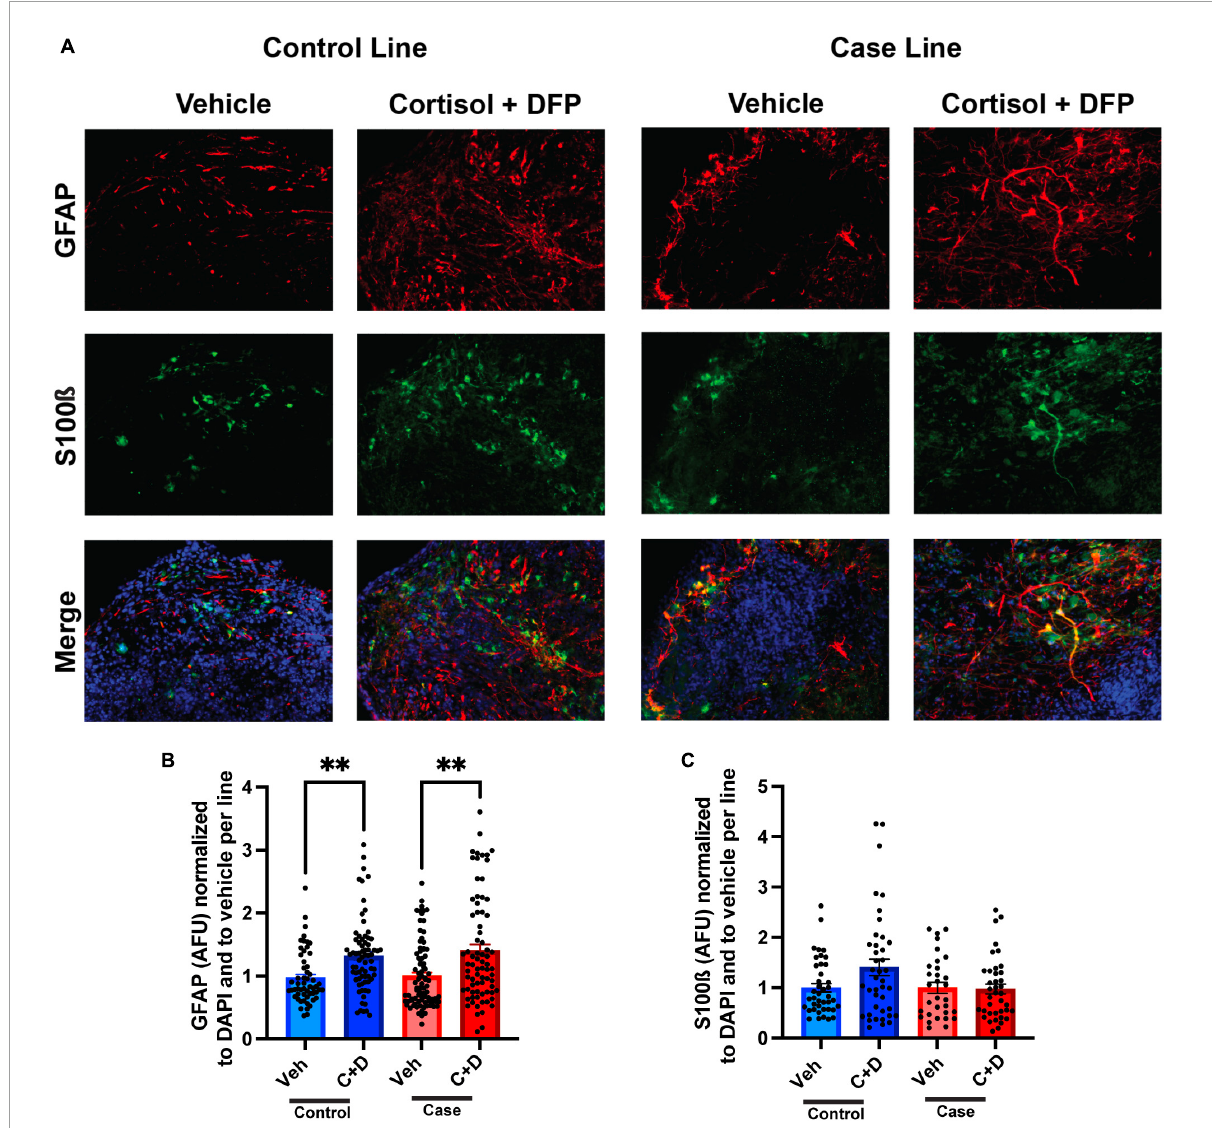
FIGURE4 Reactive astrogliosis in forebrain cerebral organoids exposed to a Gulf War (GW) toxicant regimen. (A) Representative immunofluorescence images from one control line and one case line exposed to 2 µ M cortisol plus 200 nM diisopropyl fluorophosphate (DFP) show staining for the astrocyte maker glial fibrillary acidic protein (GFAP) (red), S100ß (green), and 4, 6-diamino-2-phenylindole (DAPI) (blue). (B) The graph shows mean arbitrary fluorescence units (AFU) ± SEM normalized to DAPI per line; GFAP increased in the control line by 34.934% (0.3493 ± 0.0704) and in the case line by 40.5% (0.4050 ± 0.0960). (C) The graph shows mean AFU ± SEM of S100ß normalized to DAPI per line. ∗∗ p <